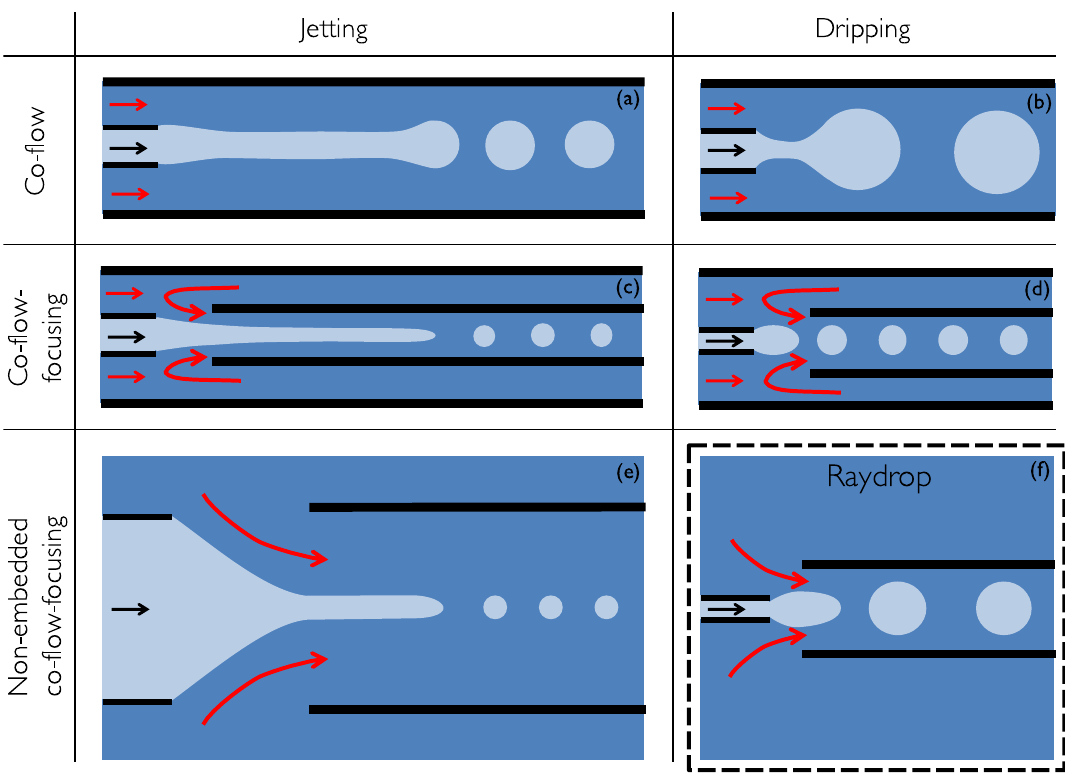
Figure 1. Capillary-based axisymetric designs of droplet generators. ( a ) and ( b ) jetting and dripping of a co-flow, respectively 20 ; ( c ) and ( d ) jetting and dripping of a co-flow-focusing in an embedded geometry, respectively 22 ; ( e ) co-flow-focusing in a non-embedded geometry, enforcing the jetting regime 25 , also referred to as tip-streaming; ( f ) Raydrop: co-flow-focusing in a non-embedded geometry, enforcing the dripping regime. All solid black lines represent capillary